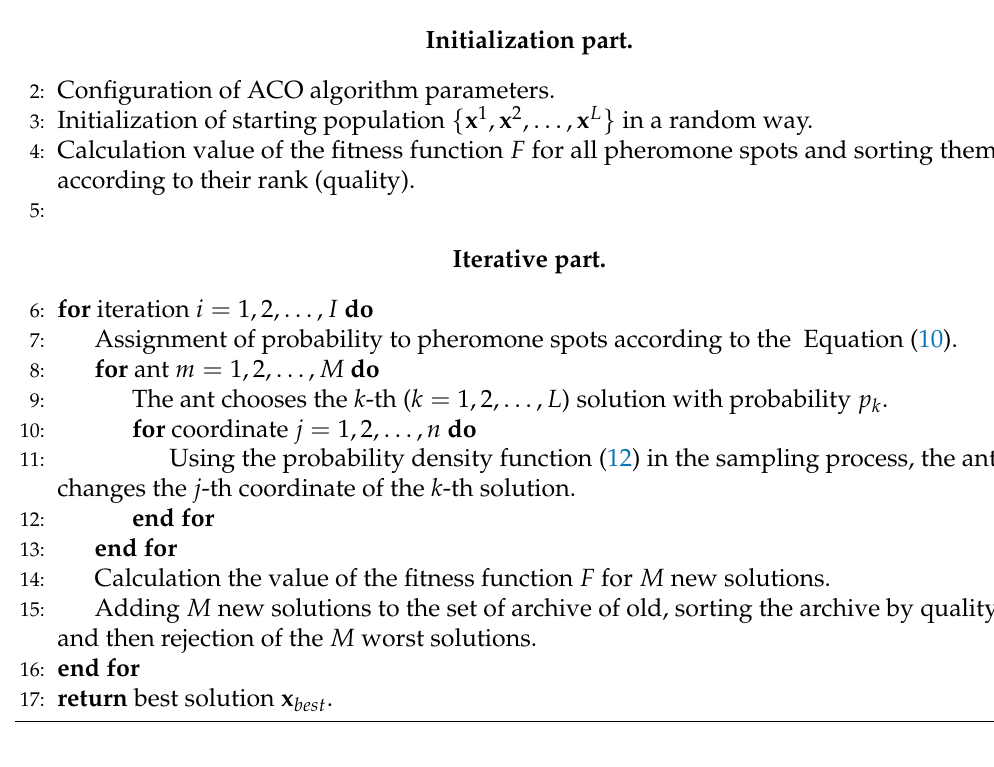
Algorithm 1 Pseudocode of ACO